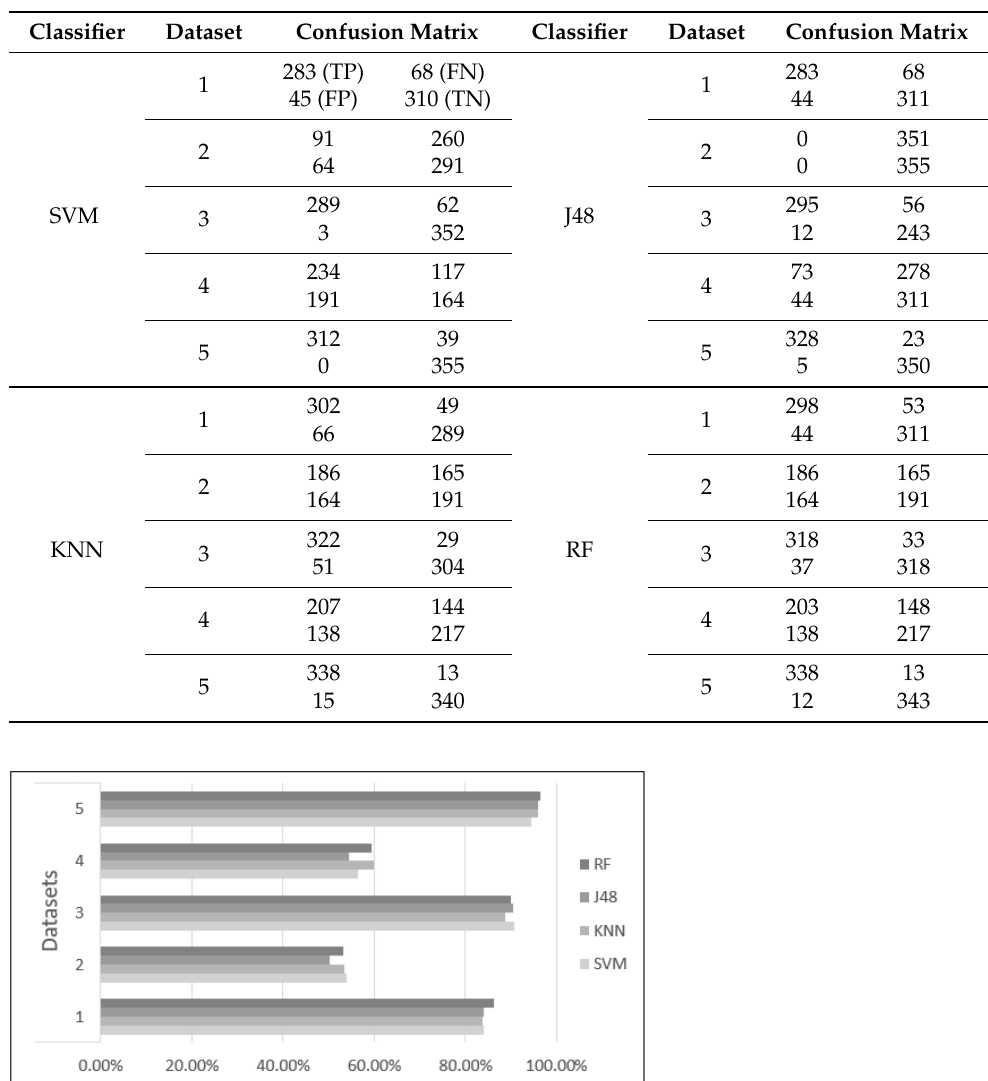
Table 4. Confusion matrix where the True Positive (TP), True Negative (TN), False Positive (FP), and False Negative (FN) values can be viewed clearly.